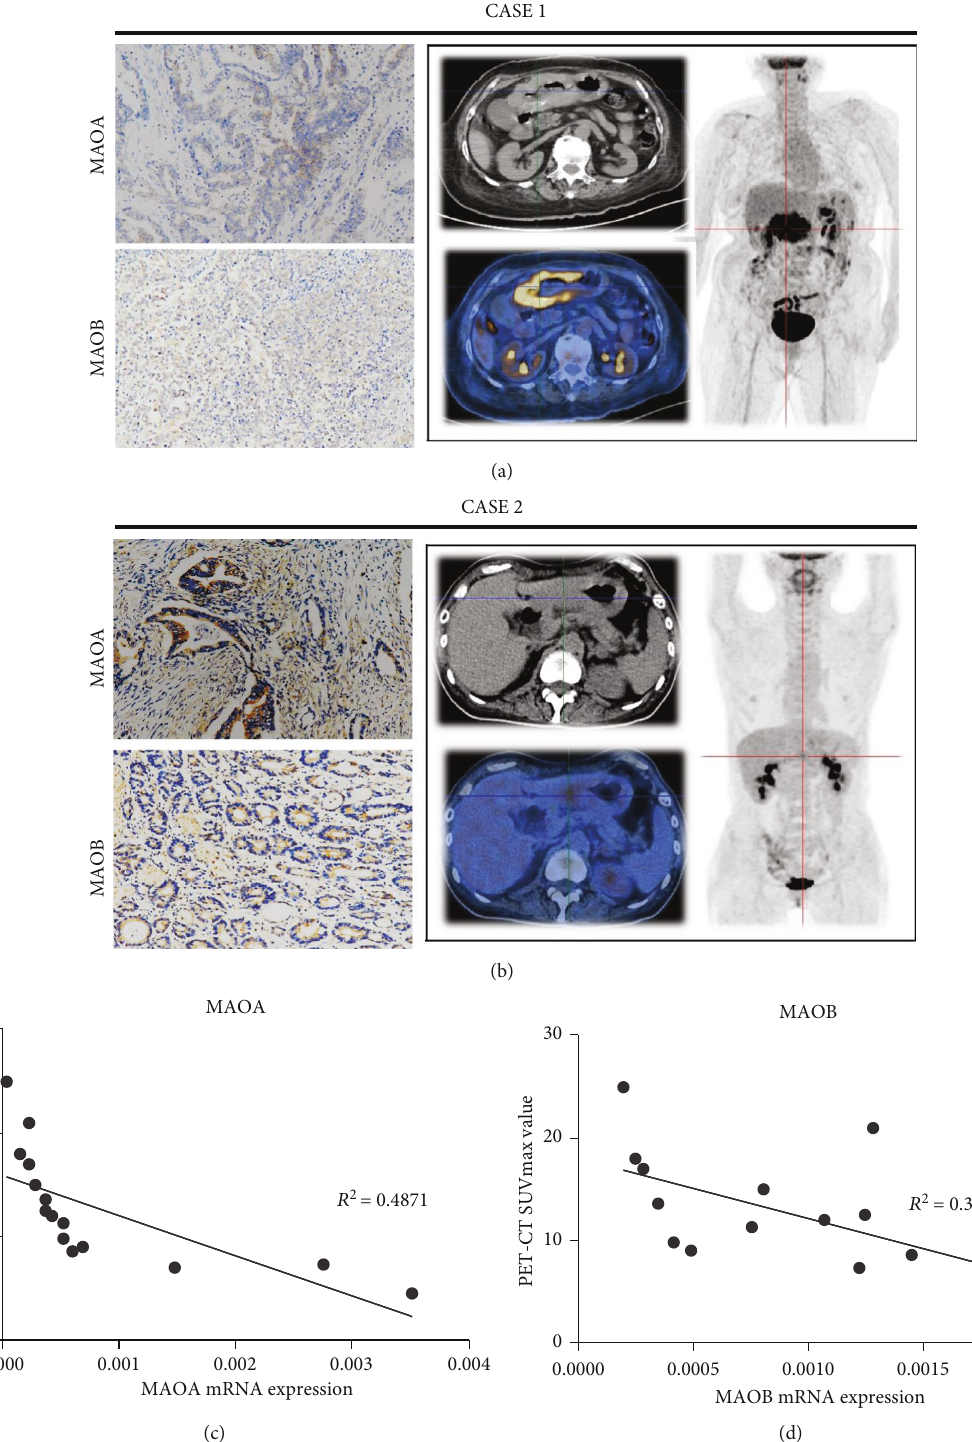
Figure 5: The MAOA and MAOB expression levels are negatively correlated with glycolysis activity. One case showed low MAOA and MAOB expression with high glycolysis activity (a). Another case showed high MAOA and MAOB expression with low glycolysis activity (b). MAOA mRNA expression was negatively correlated with the SUVmax value of PET-CT (c). MAOB mRNA expression was negatively correlated with the SUVmax value of PET-CT